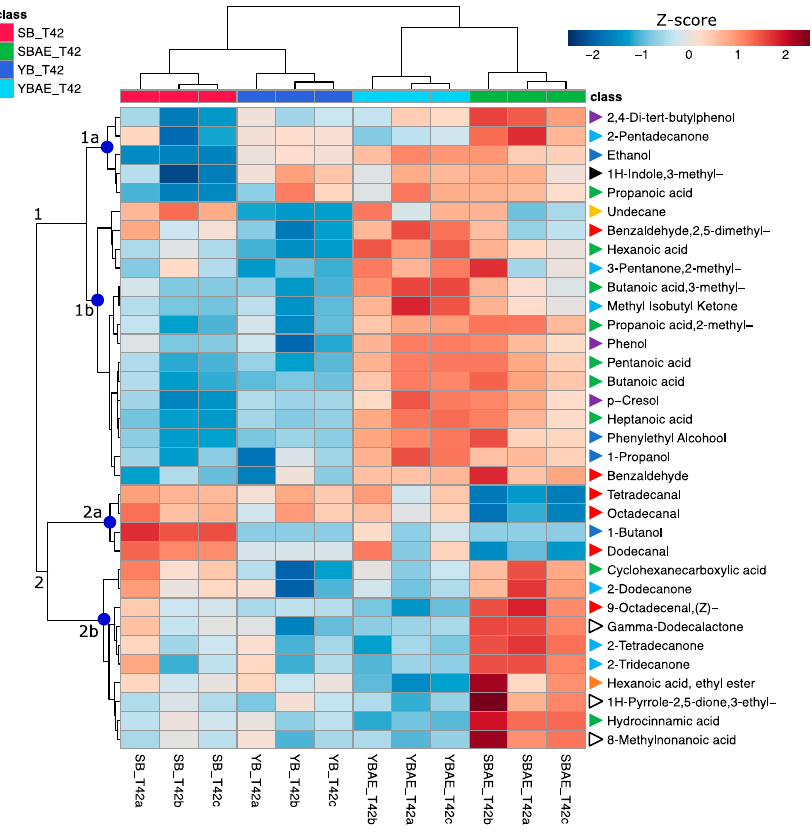
Figure 4. Heatmap with clustering (Ward’s method) of signi fi cant ( p -value < 0.05; one-way ANOVA) volatile organic compounds (VOCs) found after 42 h of fermentation in fecal batches of digested bread samples (yeast bread, YB; yeast bread with artichoke extract, YB-AE; sourdough bread, SB; and sourdough bread with artichoke extract, SB-AE). Di ff erently colored triangles indicate the chemical class: phenols (purple), ketones (light blue), alcohols (dark blue), indoles (black), organic acids (green), hydrocarbons (yellow), aldehydes (red), esters (orange), and others (white).